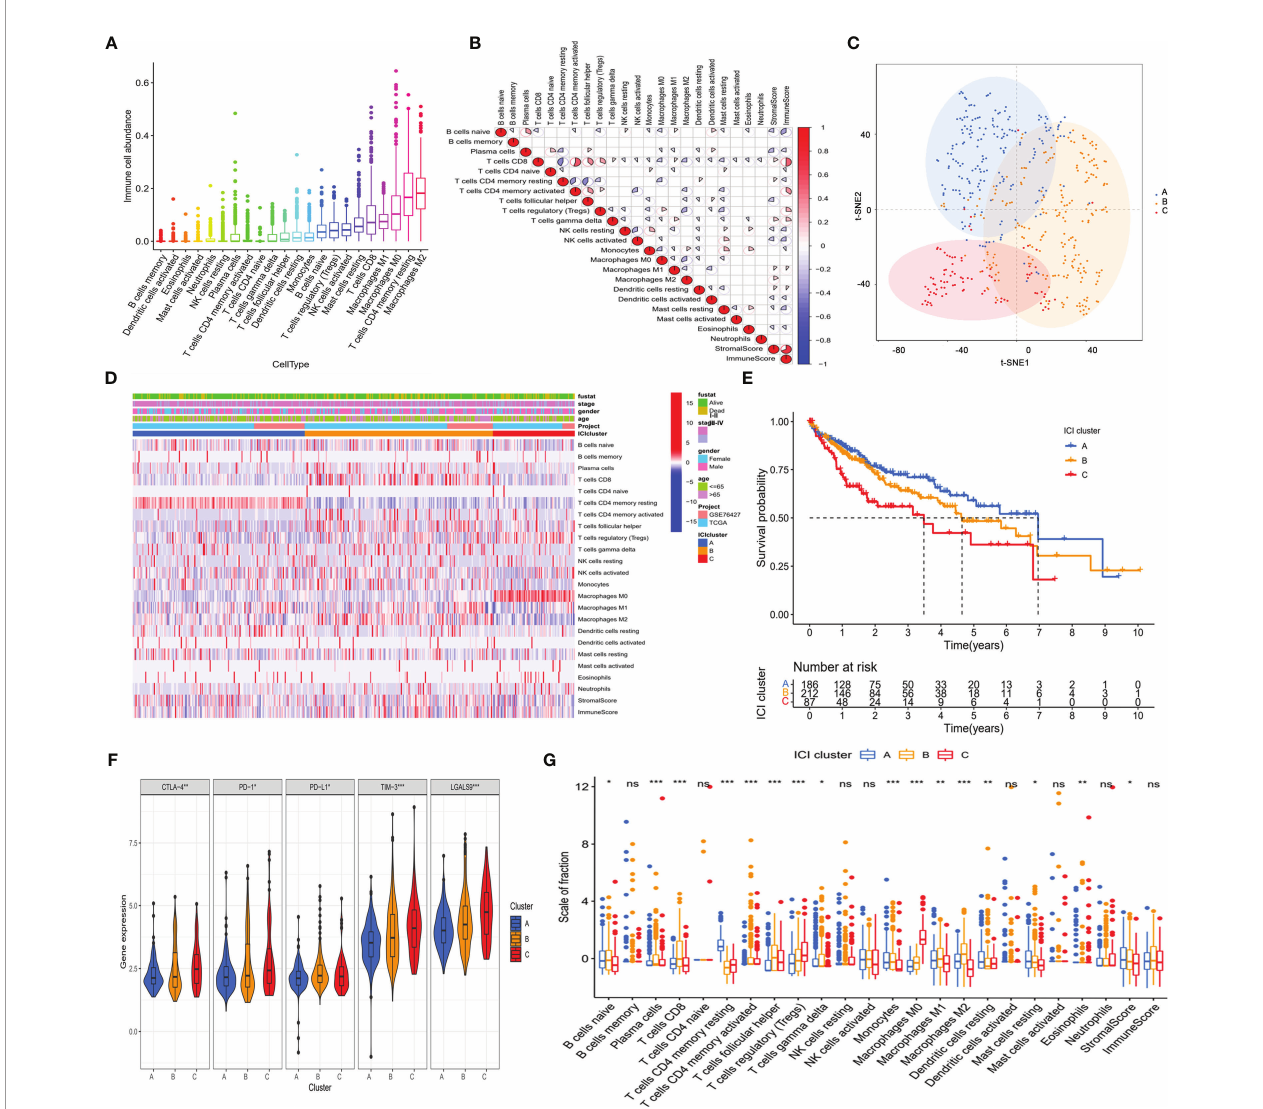
FIGURE 2 | The landscape of immuno-cell in fi ltration in the TME of HCC. (A) Comparison of the abundance of 22 tumor-in fi ltrating immune cells. (B) Correlation between the abundance of 22 tumor-in fi ltrating immune cells and Immune scores as well as Stromal scores. (C) Con fi rmation of the clustering patterns using the t- SNE algorithm. (D) Unsupervised clustering for all HCC patients based on the proportion of immune cells. (E) Kaplan – Meier survival analysis of three immune in fi ltration clusters. (F) Comparison of the expression of immune checkpoints among distinct immune in fi ltration clusters. * p < 0.05; ** p < 0.01; *** p < 0.001. (G) Comparison of fraction of tumor-in fi ltrating immune cells in immune in fi ltration clusters. * p < 0.05; ** p < 0.01; *** p < 0.001; ns, not signi fi